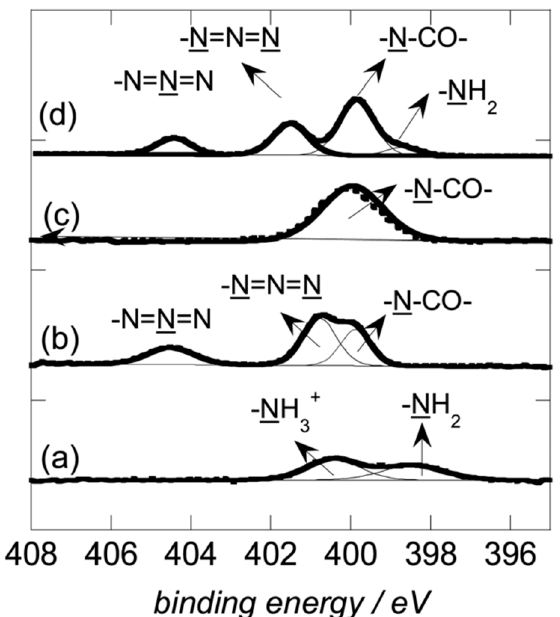
Figure 6. XPS N1s high resolution spectrum of magnetic particles modified with dopamine ( a ), dopamine-N3 ( b ), dopamine-MA ( c ), and MF-MPs ( d ). Reprinted with permission from Reference [125].